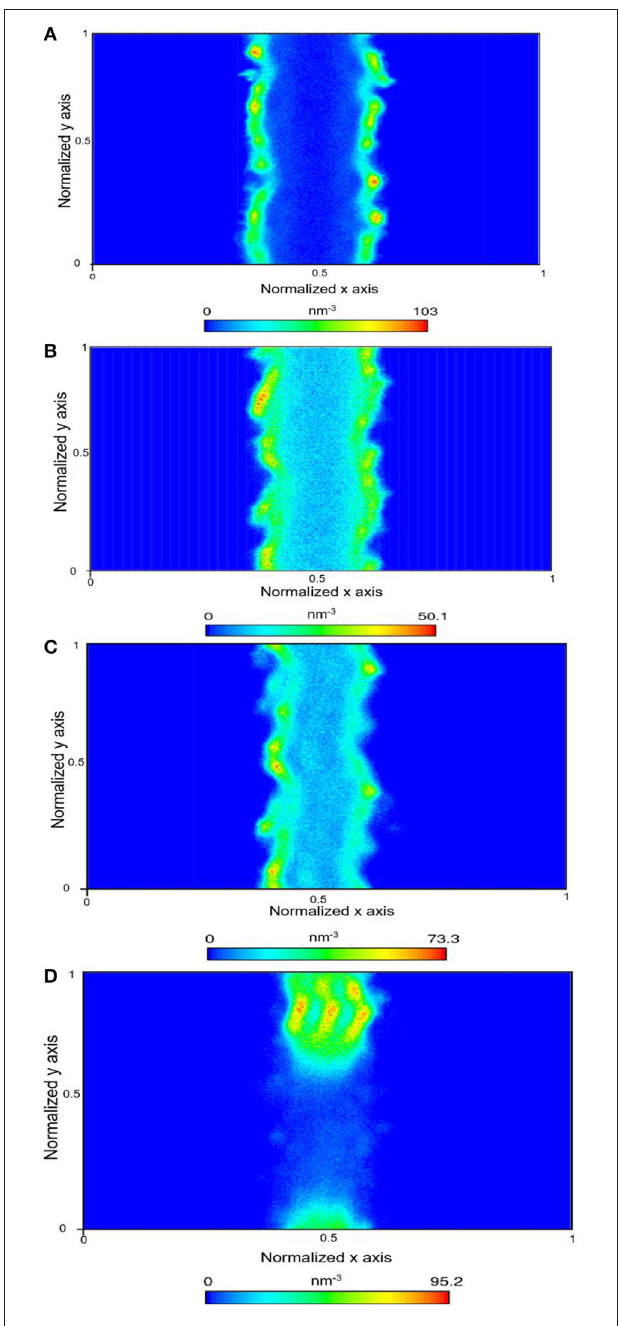
FIGURE 5 | Density map density of CH 4 within the calcite nanopore in the absence of pore water (A) , one layer of confined water composed of 150 water molecules (B) , 500 water molecules (C) , and 1,296 water molecules that correspond to a density of bulk water of 1 g/cm 3 (D) .